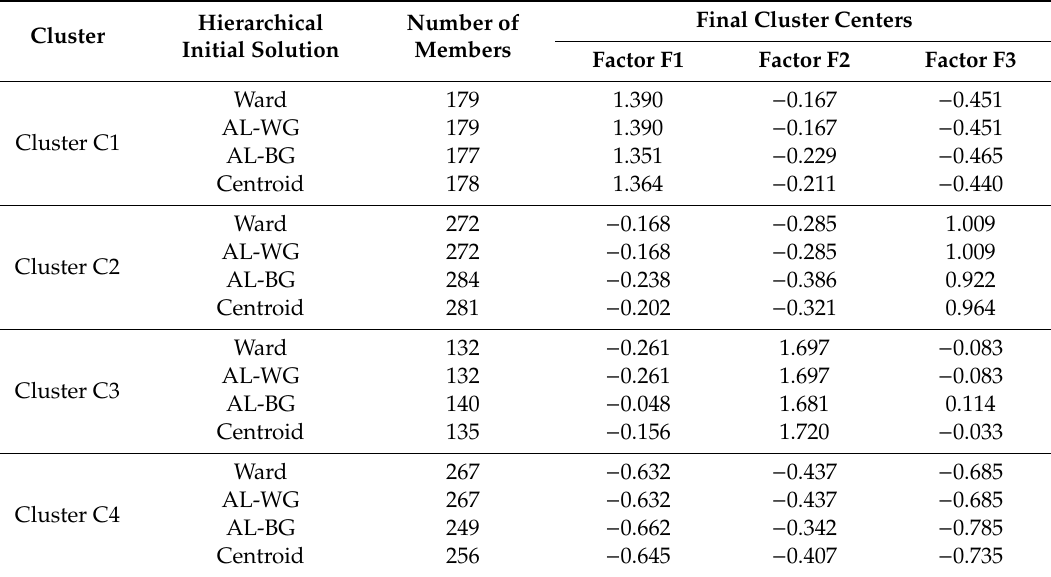
Table 9. Final cluster centers and number of